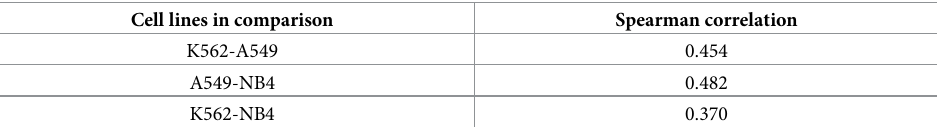
Table 1. Spearman correlation of around 5,000 sgRNAs corresponding log2fc values in K562, A549, and NB4 cell lines. These sgRNAs were used in all three cell